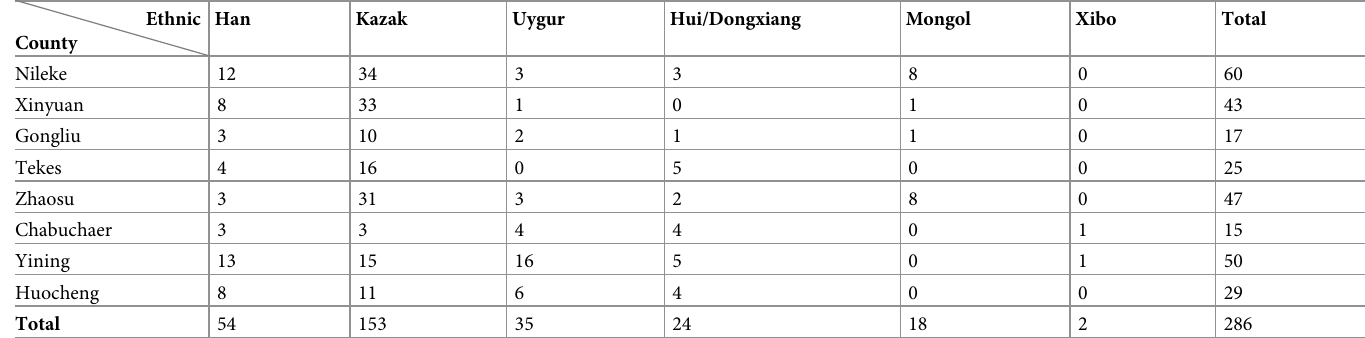
Table 3. The distribution of AE patients in different ethnic